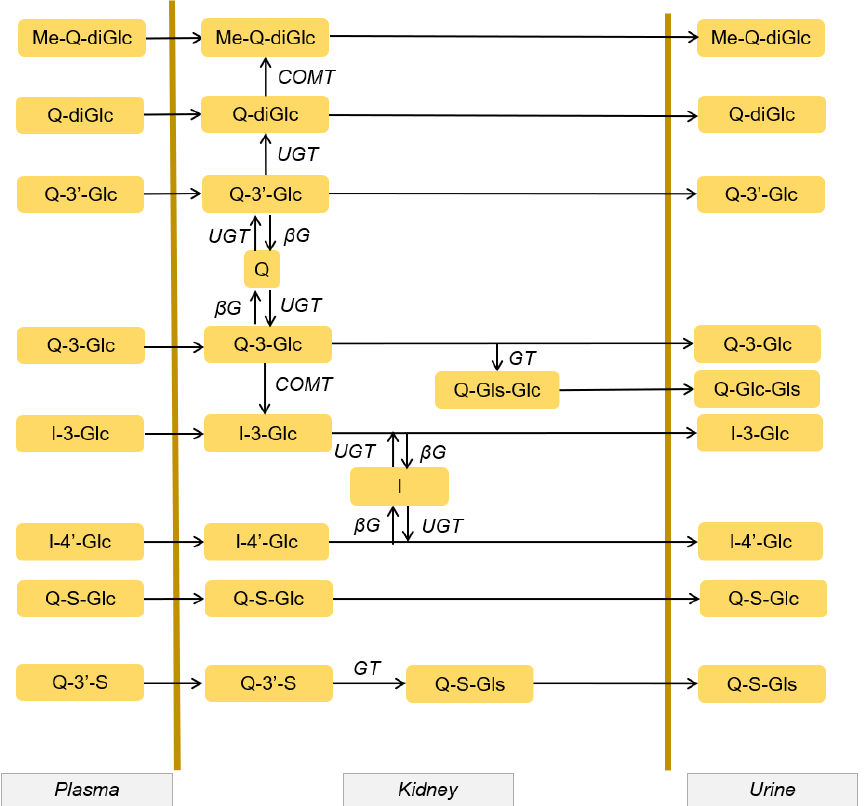
Figure 3. Hypothetical scheme of quercetin metabolism in the tubular cell. The metabolites present in plasma reach the tubular cell and undergo enzymatic transformations that increase their solubility and allow them to be excreted through the urine. Modified figure from [20], adapted with permission from British Journal of Nutrition. Gls: glucoside, Glc: glucuronide, Q: quercetin, S: sulfate, I: isorhamnetin, UGT: glucuronyltransferase, GT: glucosyltransferase, COMT: methyl- transferase, βG: β -glucuronidase. Table 2. Percentage of quercetin metabolites localized in human plasma and urine after an en- riched diet of quercetin derivatives. Data from [20].